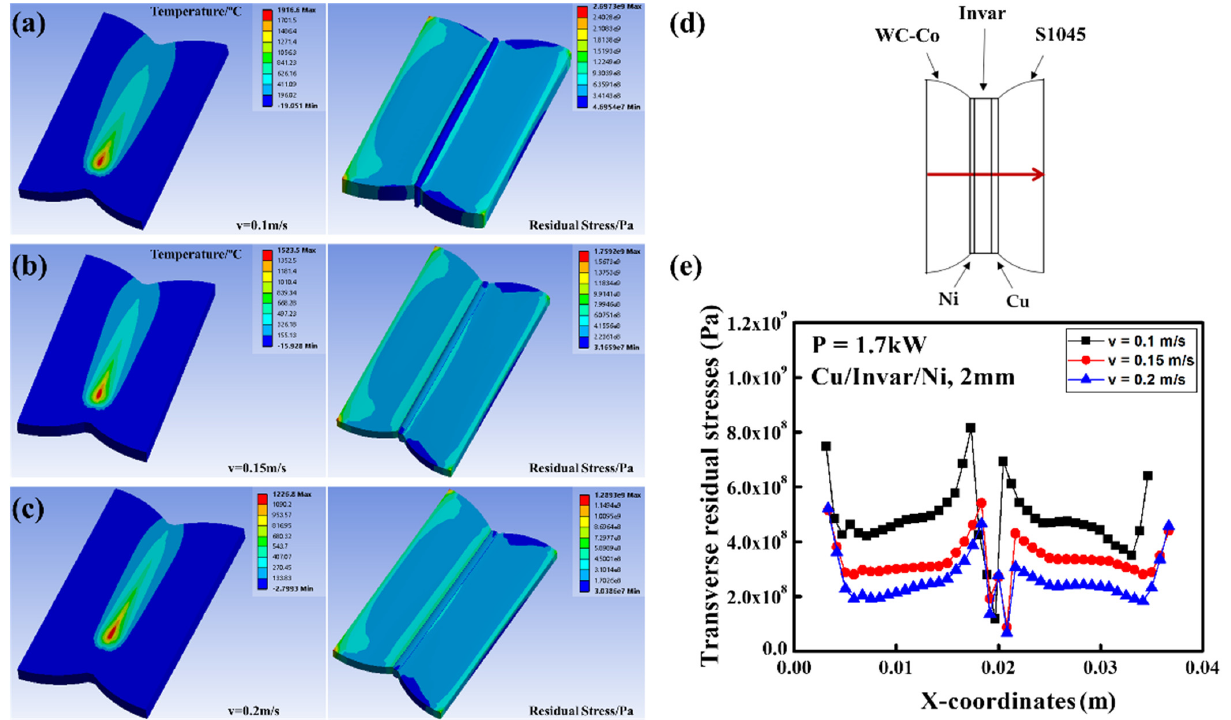
Figure 13. Simulation results of the temperature field and stress field for as − welded joints at welding speed of ( a ) 0.1 m/s, ( b ) 0.15 m/s, ( c ) 0.2 m/s, ( d ) Schematic diagram of residual stress simulation, ( e ) Comparison curve of residual stresses at different welding